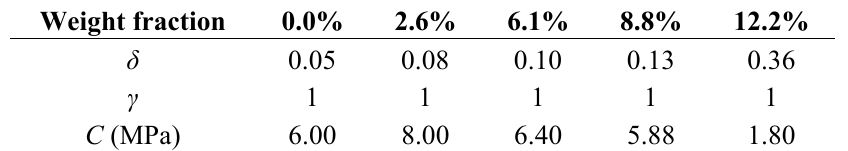
Table 2. Damage parameter values for different weight volume fractions of MWCNTs.